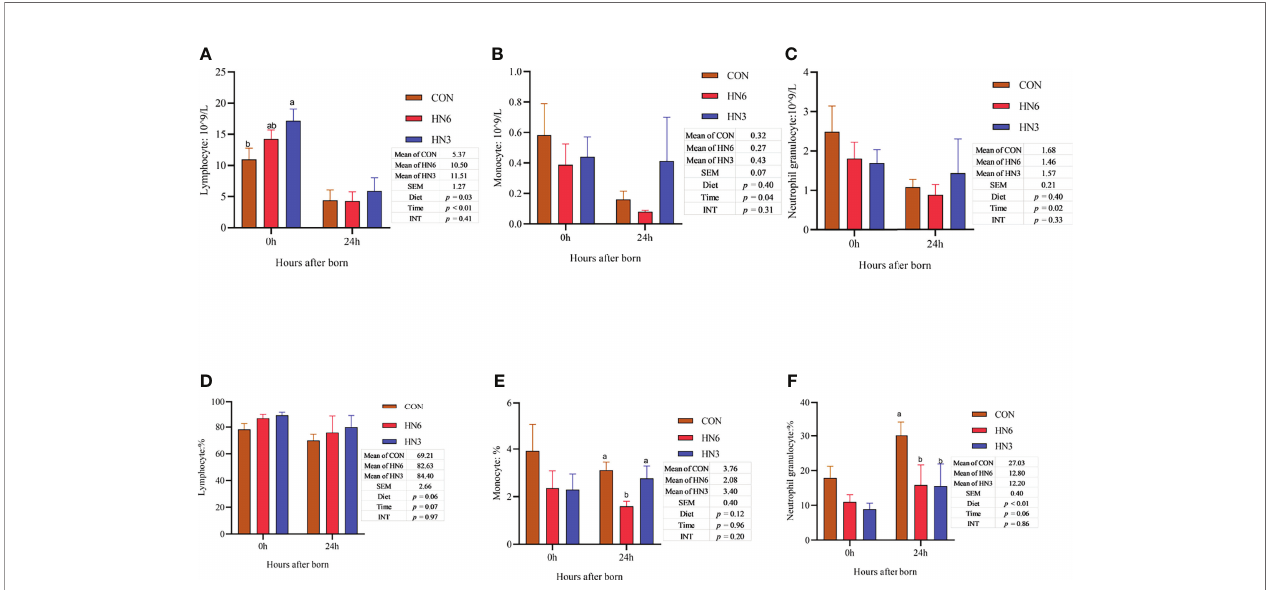
FIGURE 2 | Blood immune cell counts in neonatal calves. CON: control treatment (saturated fatty acid source), n = 12. HN3: extruded fl axseed treatment (n-3 PUFA source), n = 12. HN6: extruded soybean treatment (n-6 PUFA source), n = 13. SEM, standard error of the mean; Diet, diet treatment effect; Time, the calving time effect; INT, the interaction effect between diet effect and time effect. Values in the same sampling time point between treatments denoted by different superscript lowercase letters indicate signi fi cant differences ( p < 0.05), whereas those denoted by the same letters or no letters are not signi fi cantly different ( p > 0.05). (A – C) : the blood immune cell counts in neonatal calves; (D – F) : the percentage of the blood immune cell in neonatal